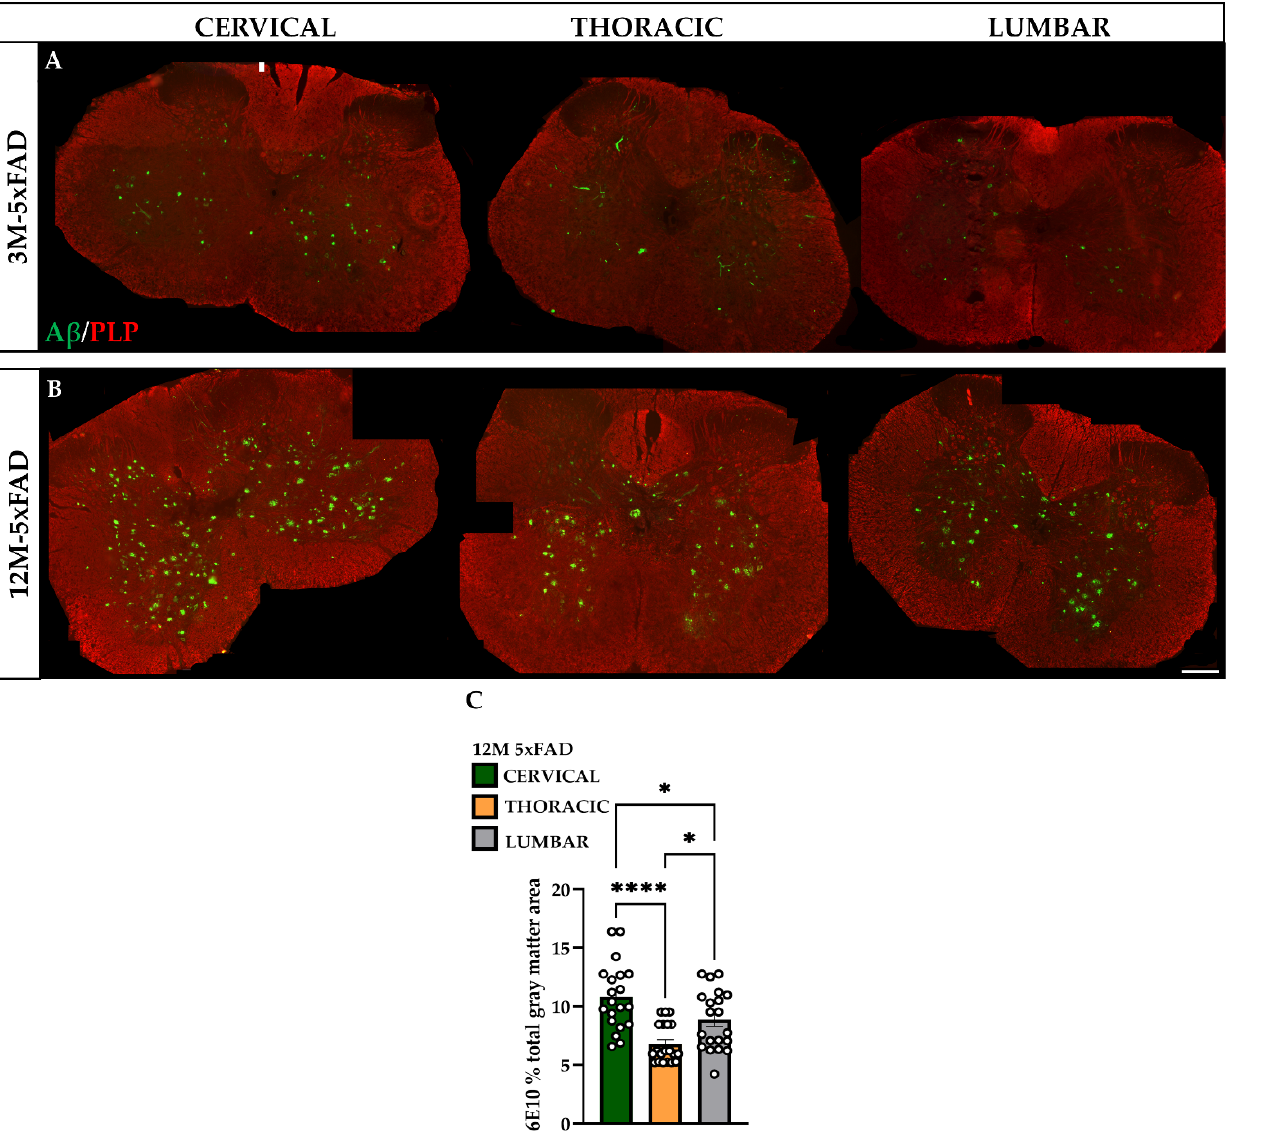
Figure 1. Age-related progressive A β accumulation in the spinal cord of 12M 5xFAD mice. ( A , B ) Spinal cord cross-sections (12 µ m thick) of 3M and 12M 5xFAD mice stained with 6E10 (green) primary antibody revealed individual plaques (green dots) in the cervical (C2), thoracic (T2), and lumbar (L2) GM sections that progressively increased with age in 12M compared with 3M 5xFAD mice. ( C ) Quantification of the percentage of the total GM area occupied by 6E10 antibody showed the highest deposition of A β senile plaques in the cervical and lumbar sections of 12M 5xFAD mice compared with thoracic sections. Statistical analysis was performed by one-way ANOVA followed by Kruskal–Wallis multiple comparisons test ( n = 6 for all genotype and age groups). Data are presented as mean ± SD. Scale bars = 100 µ m. Significance is given as: * p < 0.05, **** p <